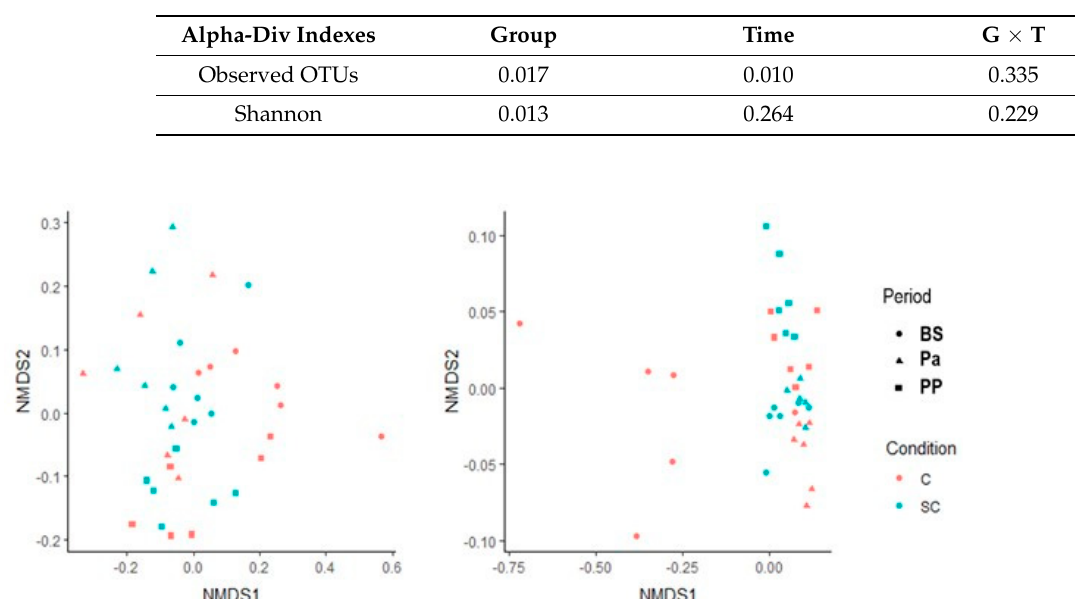
Table 4. p -values associated with the statistical analysis of the alpha diversity indexes of the bacterial and archeal communities in the fecal samples with a linear mixed model.